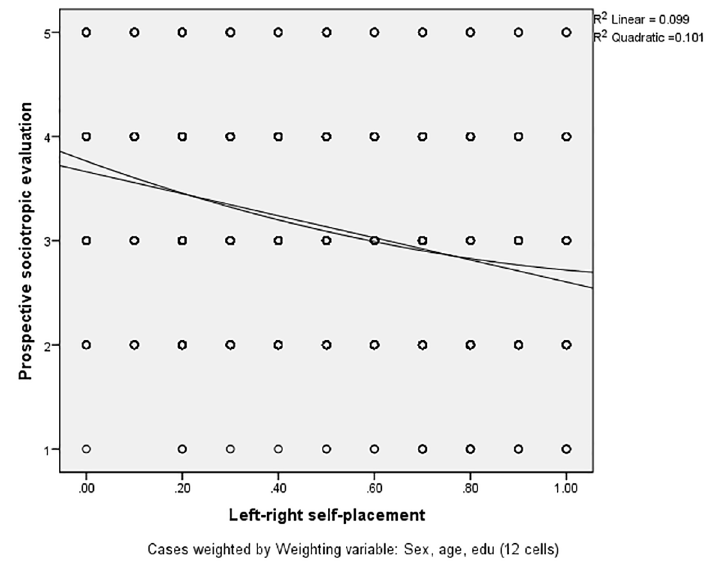
Figure 11. Linear and quadratic relationship between political ideology and negative prospective sociotropic economic